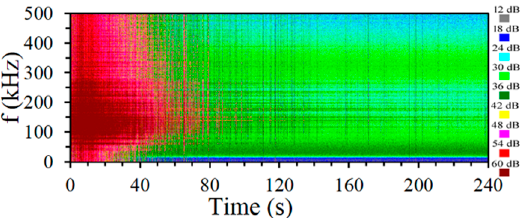
Figure 9. AE signal spectrogram for steel bearing during austempering at 150 °C: the colors encode the square root value of the signal power spectral density.